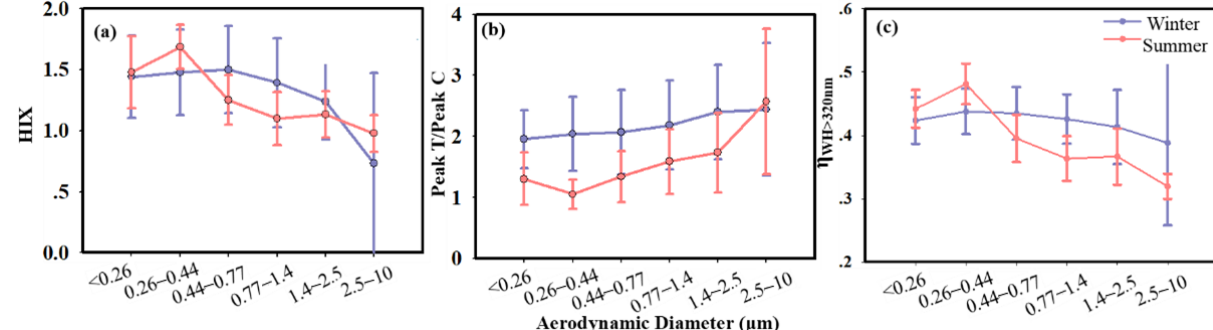
Figure 5. The humidification index (HIX) and the Peak T / Peak C ratio served as indictors of the humification degree and the possibility of the biodegradation of WSOCs. Panel (a) shows the HIX for different particle sizes, with a large HIX value indicating a high humification degree or high aromaticity for fluorescent organics. Panel (b) shows the Peak T / Peak C ratios for different particle sizes, with a large value indicating more microbial metabolites in the fluorescent organics. Panel (c) shows the size distributions of η WH > 320 for the winter and summer samples,